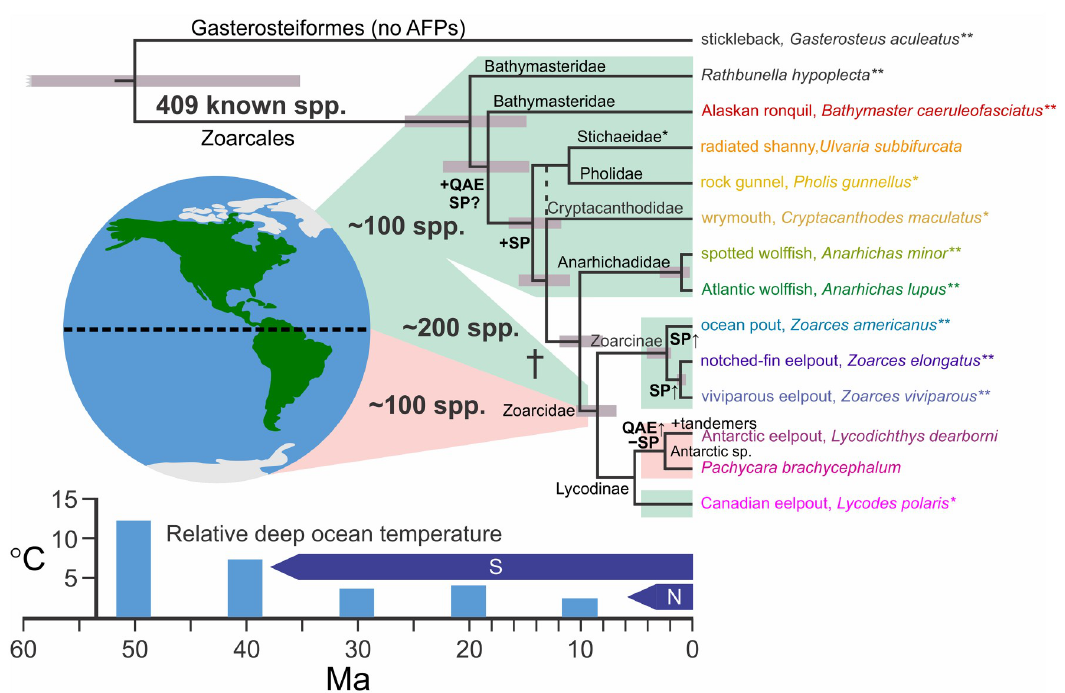
Fig 1. Detailed relationships among species of the infraorder Zoarcales discussed in this study. Divergence times were obtained from the following studies; Gasterosteiformes and Zoarcales, from 21 loci from a broad range of teleost fishes [19], Bathymasteridae, from 10 nuclear genes [88] and within Zoarcales [42] or Anarhichadidae [89] using fewer loci. A double asterisk denotes that the fish from these studies was the same as the species in this study, whereas a single asterisk denotes that the fish was a different species within the same genus. The 95% posterior density intervals for the branch points are shown by grey bars. Species names are coloured in a rainbow pattern from red to purple from earliest to latest time of divergence of each family. The location of the Cryptacanthodidae varies between studies (denoted with a dotted line) [19, 46] and some Stichaeidae cluster with Pholidae [44–46]. Information on Lycodinae and radiated shanny was limited. Therefore, their relationship to the others was determined using the COX gene with Alaskan ronquil as the outgroup (S2 Fig), with divergence times estimated from the nearest calibrated node. The nodes at which there is the earliest evidence for the presence (+) or absence (-) of SP or QAE isoforms are indicated, as well as branches along which gene duplications have occurred (SP " ). The number of known Zoarcales species and their range (green background for northern, pink for southern) was determined from FishBase [72]. The average temperature of the deep ocean, relative to the present day, as well as the temporal extent of northern (N) and southern (S) glaciation, was adapted from Fig 1 of [90].